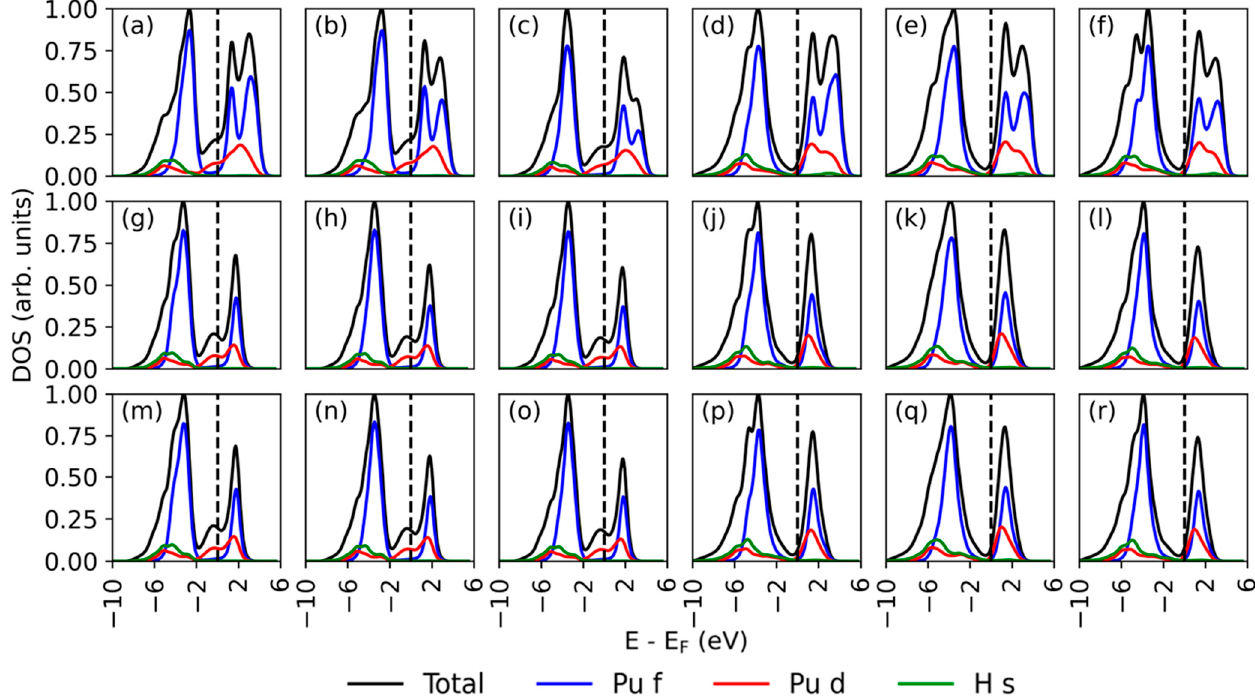
Figure 7. eDOS plots calculated using PBEsol+ U +SOC ( U = 5 eV) for cubic PuH 2 /PuH 3 with: FM ( a , d ) <100>, ( b , e ) <110> and ( c , f ) <111>; longitudinal AFM ( g , j ) 1k, ( h , k ) 2k, and ( i , l ) 3k; and transverse AFM ( m , p ) 1k, ( n , q ) 2k, and ( o , r ) 3k. The Fermi level is at 0 eV denoted by a vertical dashed line.